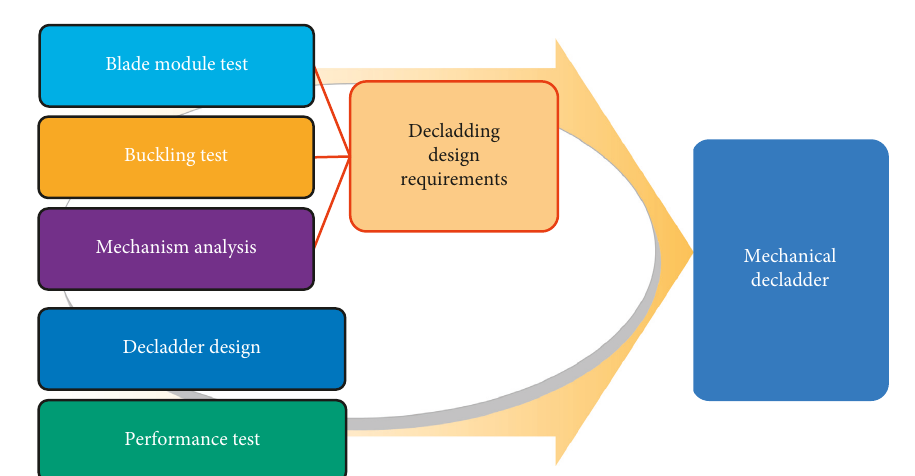
Figure 2: Design considerations.